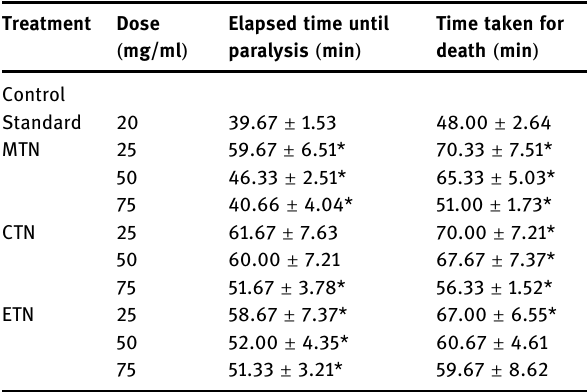
Table 4: Anthelmintic activity of T. nudi fl ora leaves extracts at di ff erent doses